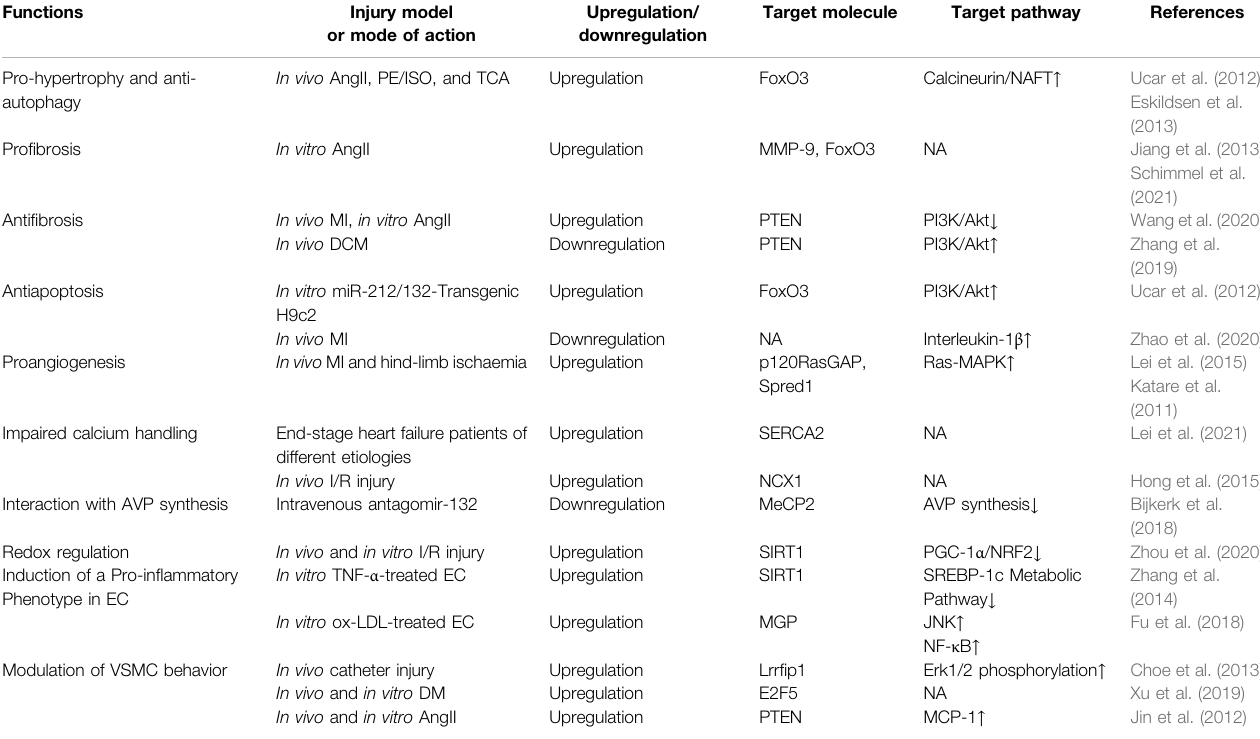
TABLE 2 | MiR-132 targets and functions in pathophysiologic process of cardiovascular disease.